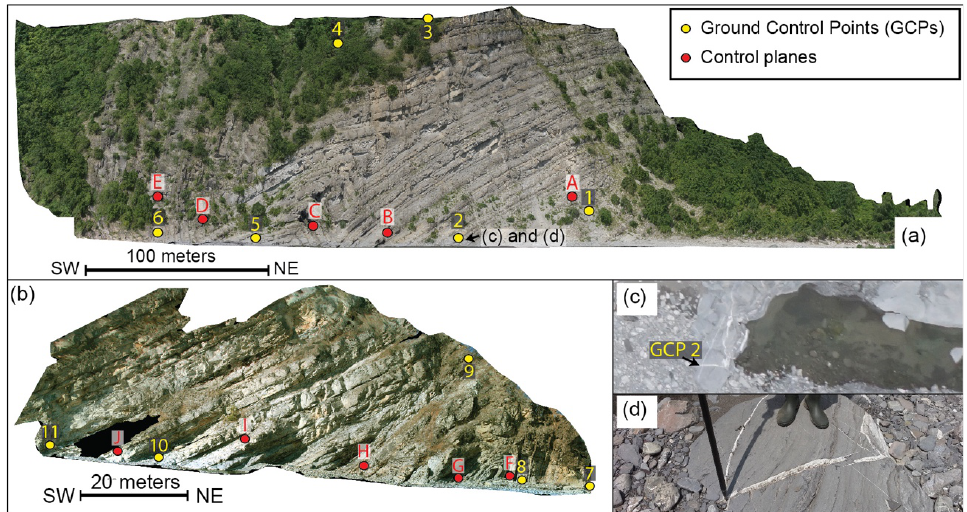
Figure 4. Orthorectified images of Digital Outcrop Models DOMs representing outcrops 1 ( a ) and 2 ( b ). The view points of the orthorectified images are horizontal and sub-orthogonal to the mean slope direction. The position of the GCPs and the control planes (natural surfaces whose attitude was measured in the field and on the DOMs) are indicated with yellow and red dots, respectively. The position of GCP 2 is shown in a Unmanned Aerial Vehicle (UAV) ( c ) and field ( d ) images.